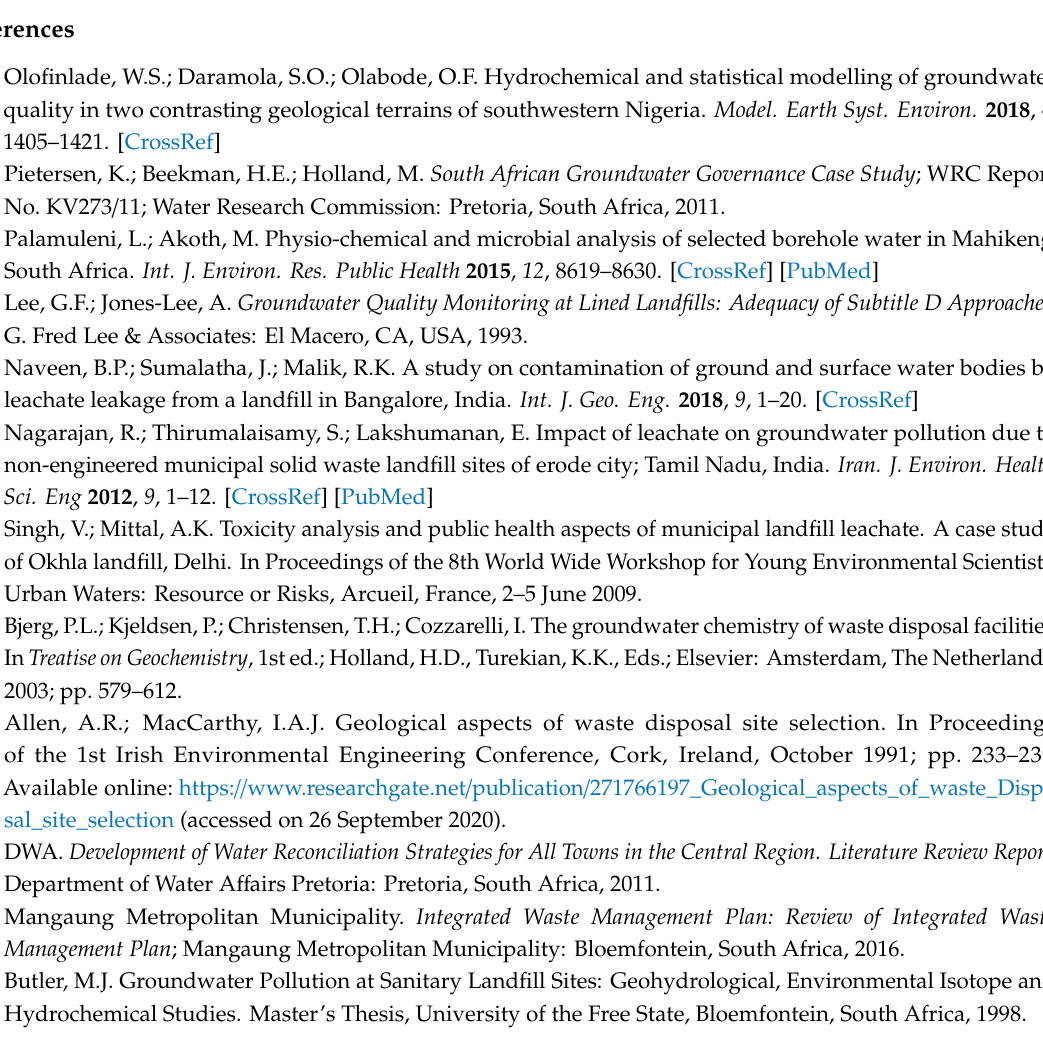
Supplementary Materials: The following are available online. Figure S1: Map illustrating the two landfill sites in Bloemfontein and the location of the pollution monitoring boreholes in the vicinity of the two landfill sites, Figure S2: Schematic presentation of the Karoo Supergroup sequence, Figure S3: Piper diagram for the groundwater samples in the northern landfill site for the two seasons, Figure S4: Piper diagram for the groundwater samples in the southern landfill site for the two seasons. Figure S5: Expanded Durov diagram for groundwater samples in the northern landfill site for the two seasons, Figure S6: Expanded Durov diagram for groundwater samples in the southern landfill site for the two seasons, Figure S7: Salinity hazard (SAR) diagram for the boreholes in the northern landfill site, Figure S8: SAR diagram for the boreholes in the southern landfill site, Figure S9: Well-constructed borehole in the northern landfill site, Figure S10: Poorly constructed borehole in the southern landfill site. Table S1: Water quality parameters groundwater samples collected in the autumn and winter seasons from the northern and southern landfill sites, Table S2: Comparison of the average physicochemical and microbiological parameters of the two landfill sites over two